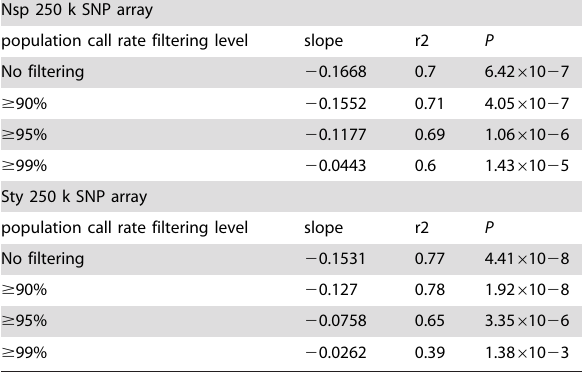
Table 3. Relationship between array call rate and LCL versus PBMC mismatch rate, for Nsp and Sty arrays, at different levels of SNP filtering by population call rate.